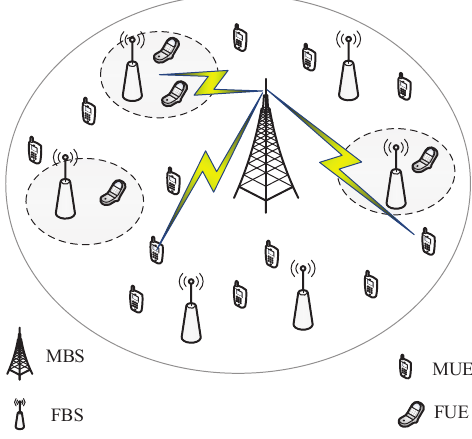
Figure 1. Two-tier macro-femto networks architecture.